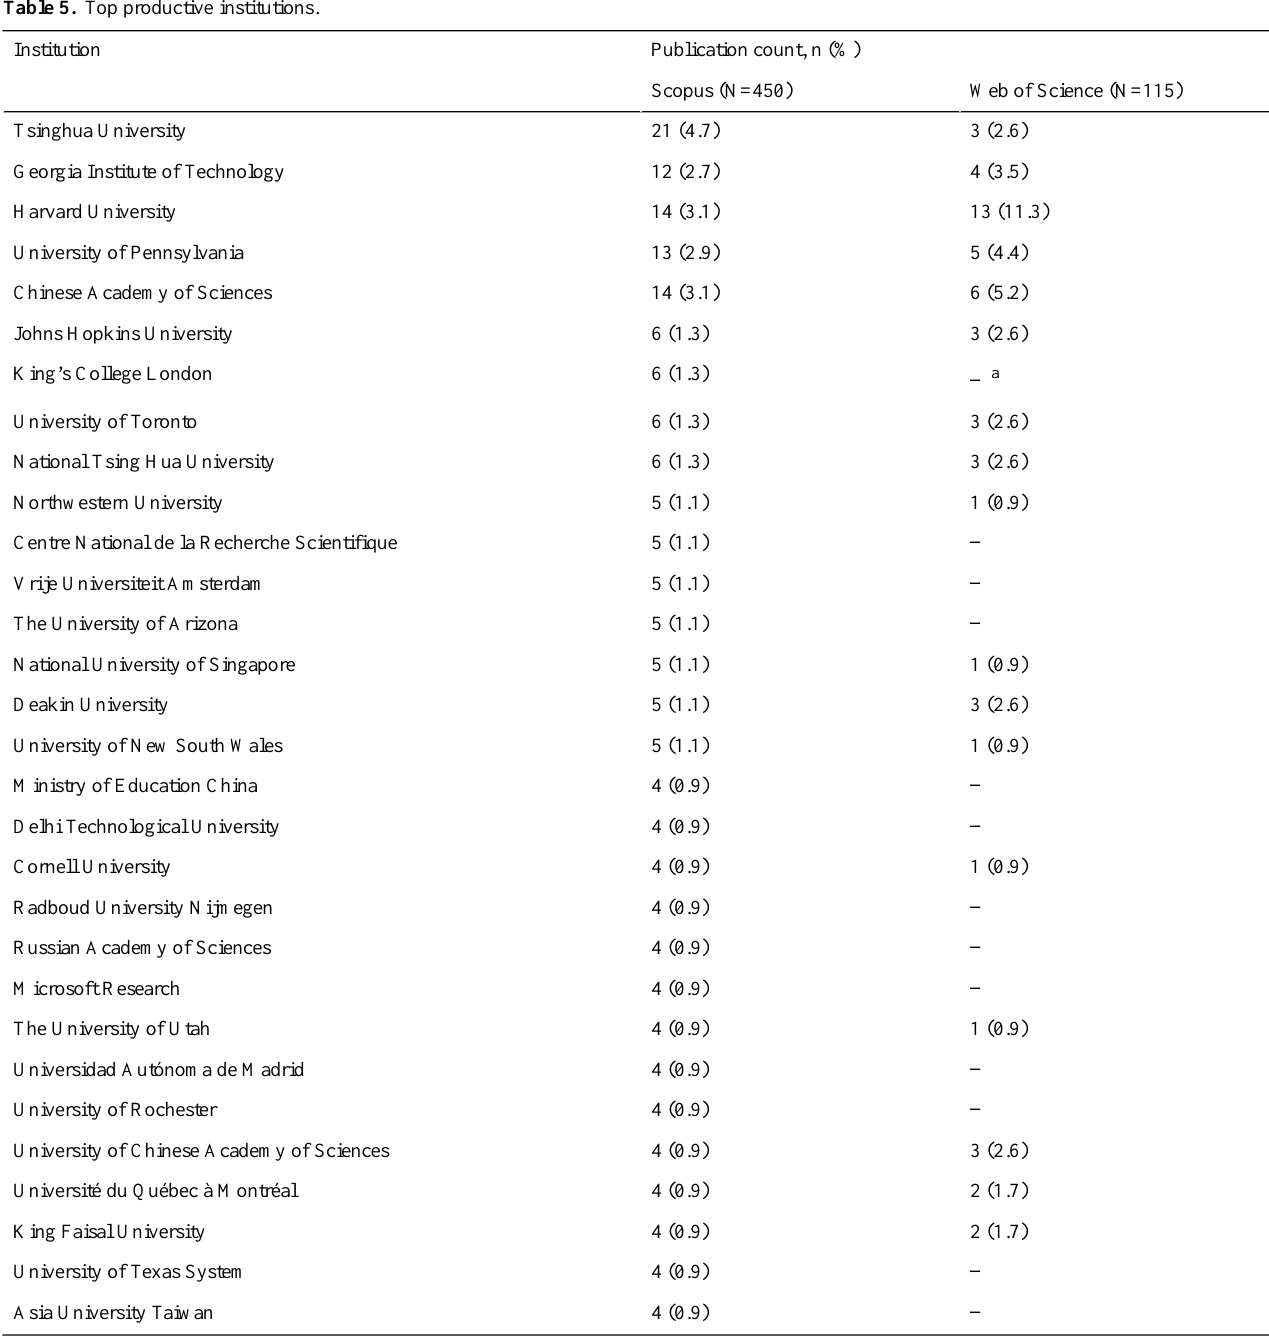
Table 5. Top productive